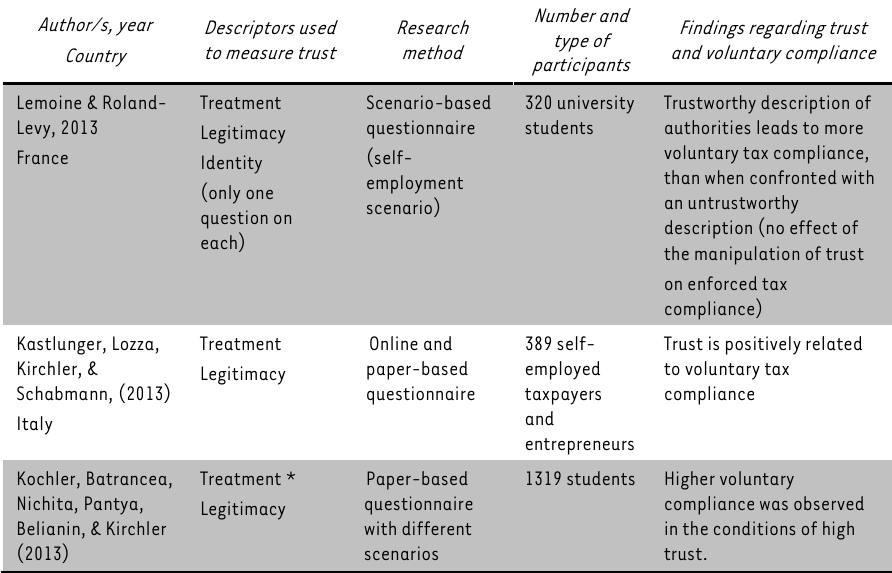
Analysis of studies relating to trust and tax compliance